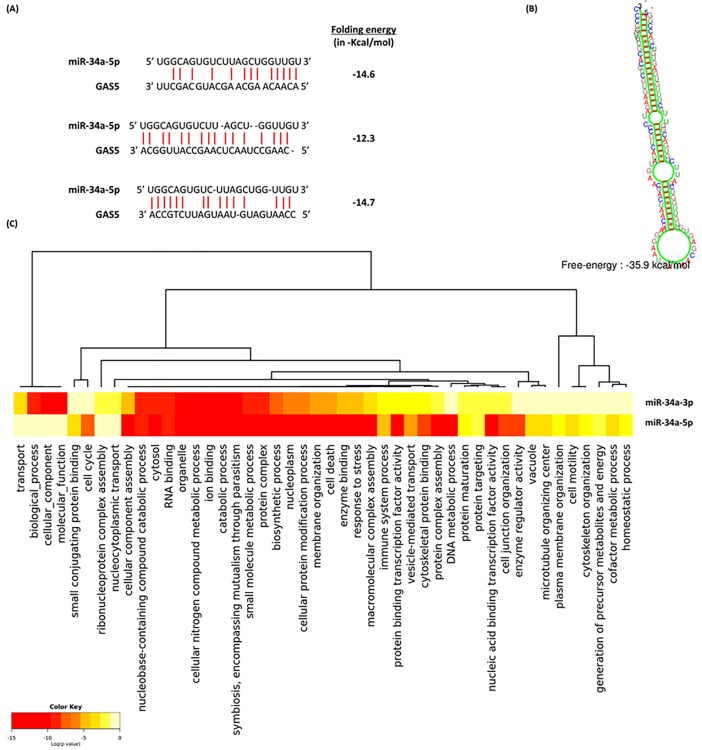
Functional and structural analysis of miR-34a.(A) GAS5: miR-34a-5p interaction. Complementarity regions are shown in three binding sites in GAS5 gene, one proximal at 5' region (1432–1455) and two distal at 3' end (3545–3567 and 3698–3719) [Data source: RNA22, DIANA-LncBase v2]. (B) Predicted secondary structure of miR-34a. Folding pattern and energy are demonstrated [Data source: KineFold]. (C) Functional enrichment analysis of miR-34a experimentally validated gene targets. Significant clustered heat map represents the gene ontology using GO slim option, FDR conservative states, p value threshold < 0.05, and categories union [Data source: DIANA-miRPath v3]. http://snf-515788.vm.okeanos.grnet.gr/#mirnas=hsa-miR-34a-3p;hsa-miR-34a-5p&methods=Tarbase;Tarbase&selection=2.